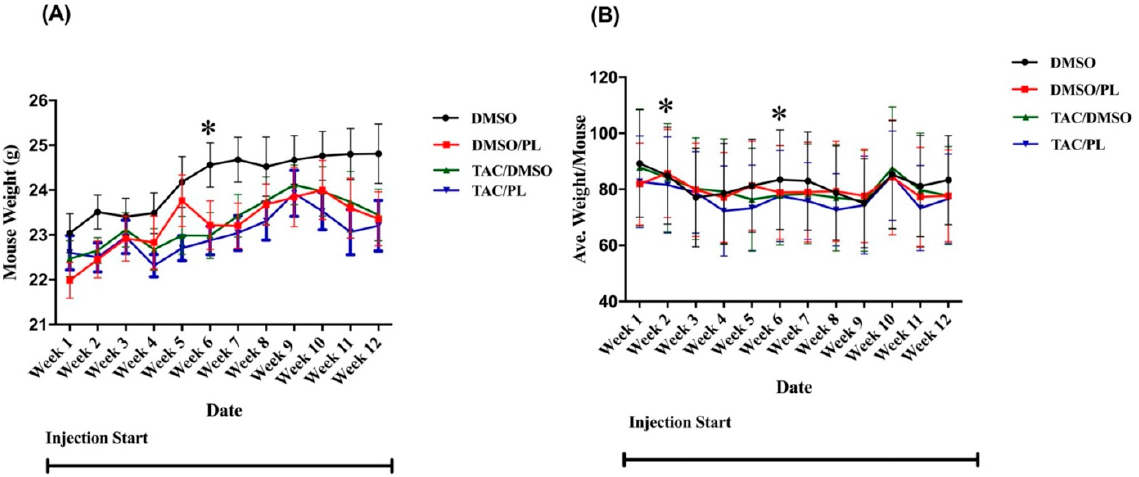
Figure 1. Mouse weights and food consumption during the injection period. ( A ) Mouse weights were significantly different between other treatment groups and control-treated animals in week 6. ( B ) Food consumption was significantly different in weeks 2 and 6. Two-way ANOVA, average ± SEM ( n = 12); Bonferroni multiple comparisons * p < 0.05.